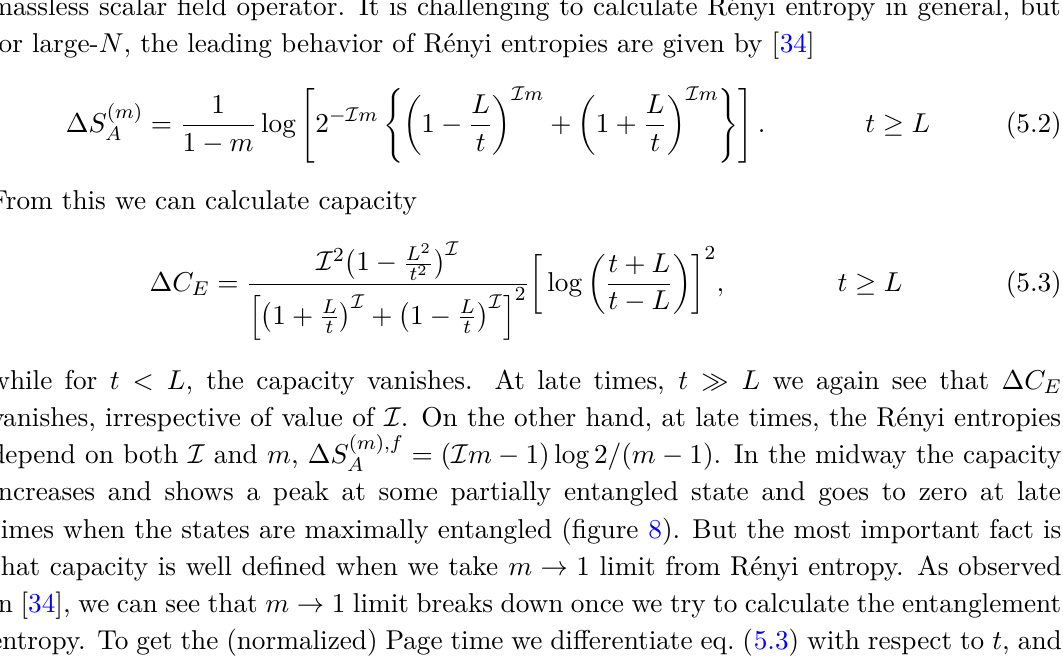
Figure 8. Plot of (a) ∆ S (2) and (b) ∆ C E for different values of I . Here we choose L = 10 . ∆ S (2) A saturates to log 2 , 3 log 2 and 5 log 2 for I = 1 , 2 and 3 respectively. On the other hand, ∆ C E peaks up a value 0 . 4392 for t = 11 . 9968 , t = 18 . 6242 and t = 26 . 3257 for I = 1 , 2 and 3 respectively. Finally it vanishes at late times for all I . The red line corresponds to t < L